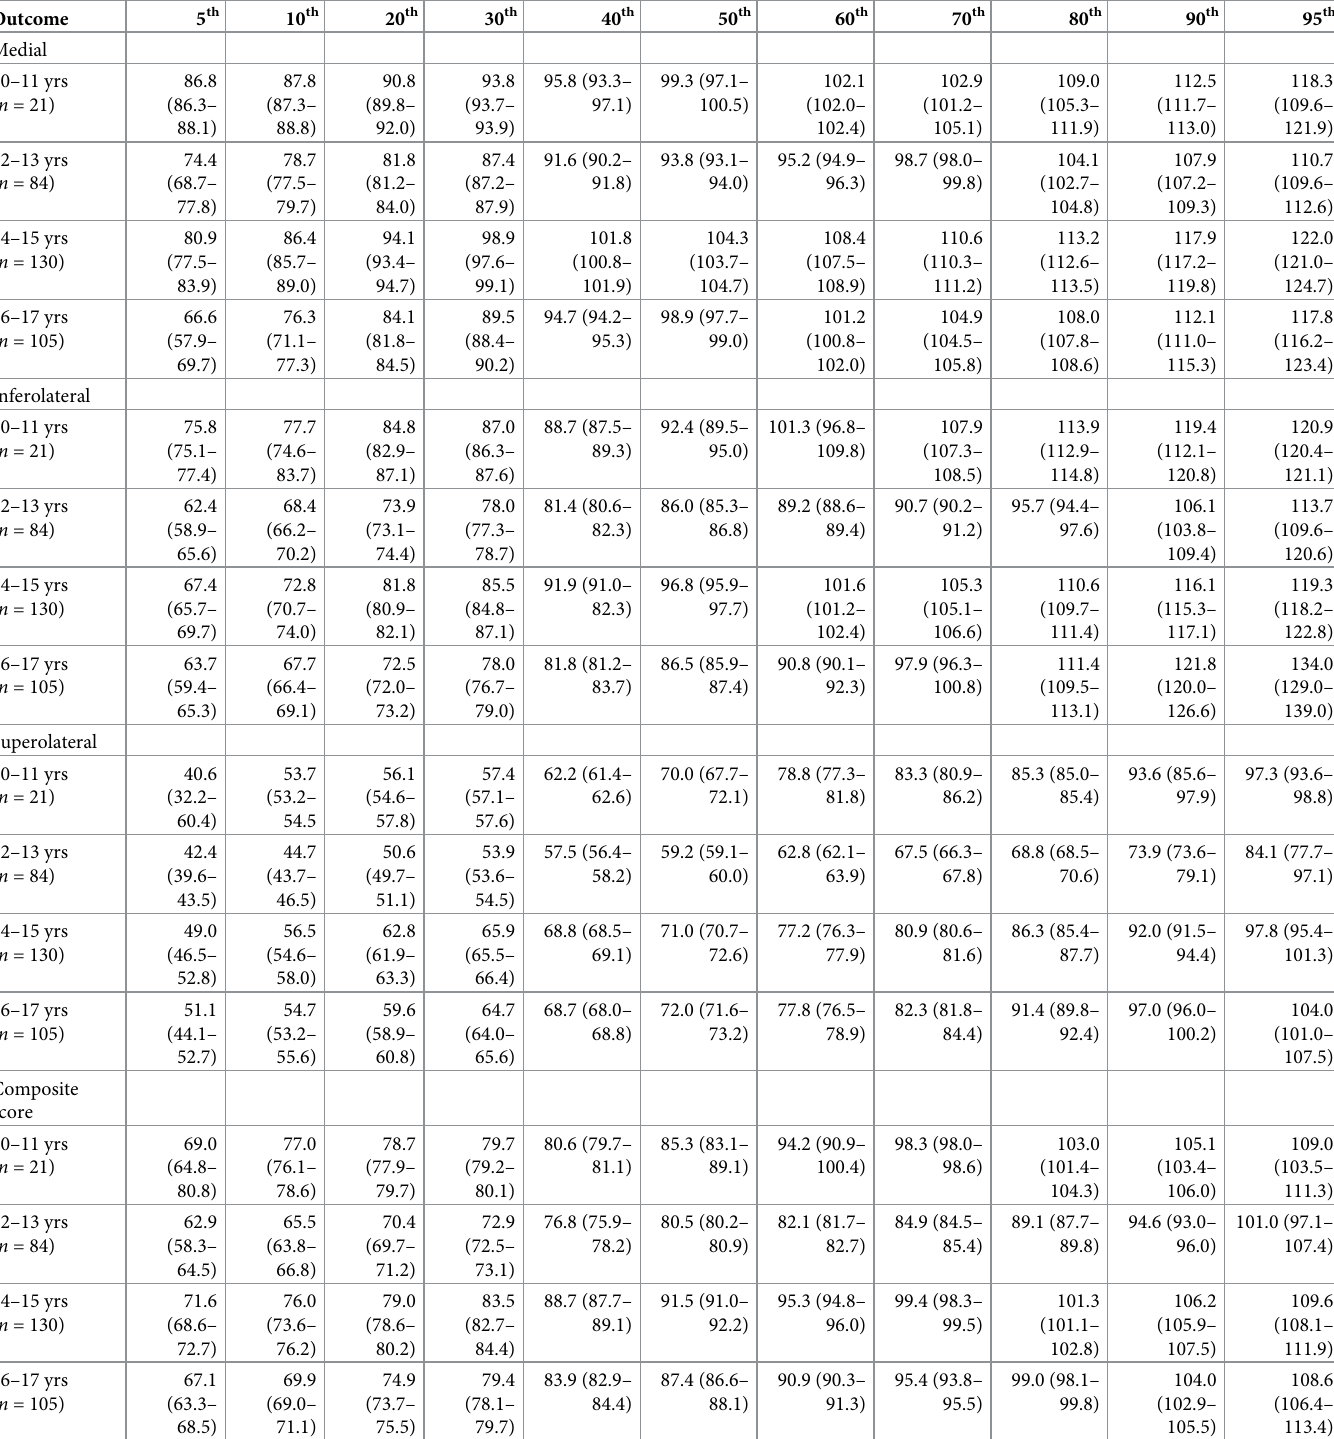
Table 4. Smoothed age-specific percentile values with 95% confidence interval for the normalized (% arm length) maximal left arm reach distances and the compos- ite score in males (n = 340) aged 10 to 17